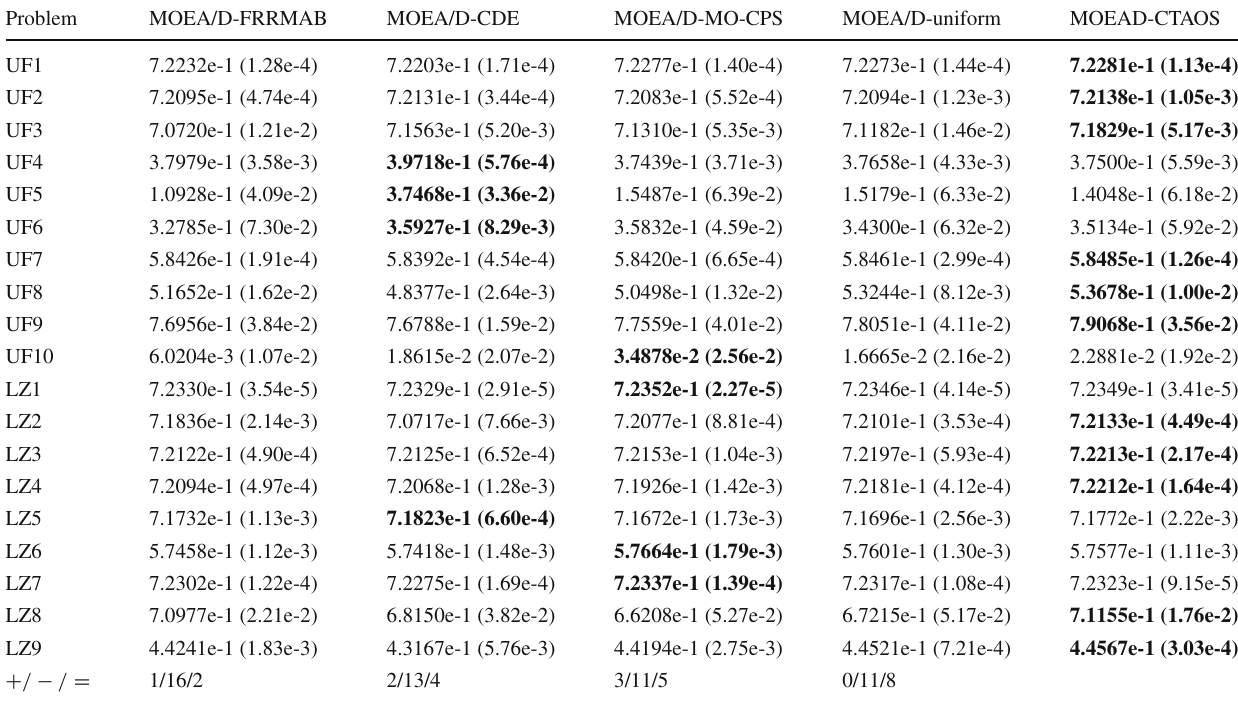
The best entries are highlighted in boldface according to the IGD or HV value Table 4 Average and standard deviation HV values obtained by MOEA/D variants with different AOS methods on each benchmark (30 runs)